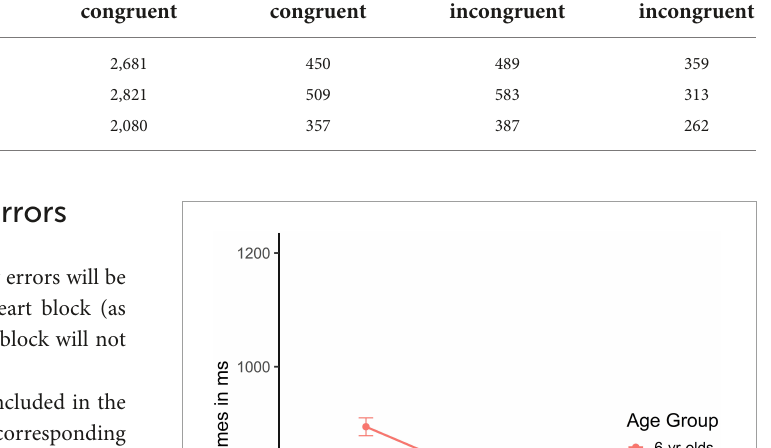
TABLE 2 Number of observations underlying the analyses concerning the different trial types in the Mixed block. Age group N Correct Incorrect Post-correct congruent